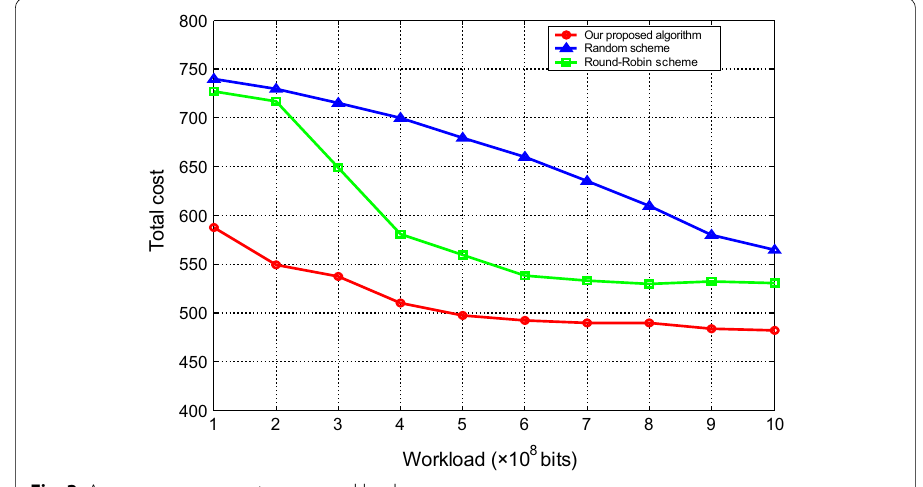
Fig. 3 Average resource cost versus workload